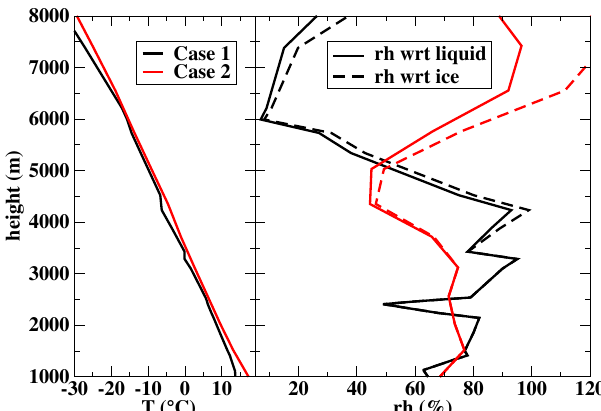
Figure 7. Vertical profiles of temperature (left) and relative humid- ity (right) with respect to liquid water (full lines) and ice (dashed lines) based on a radiosonde observation (Meiningen) for case 1 (black) and from GDAS (grid point Leipzig) for case 2